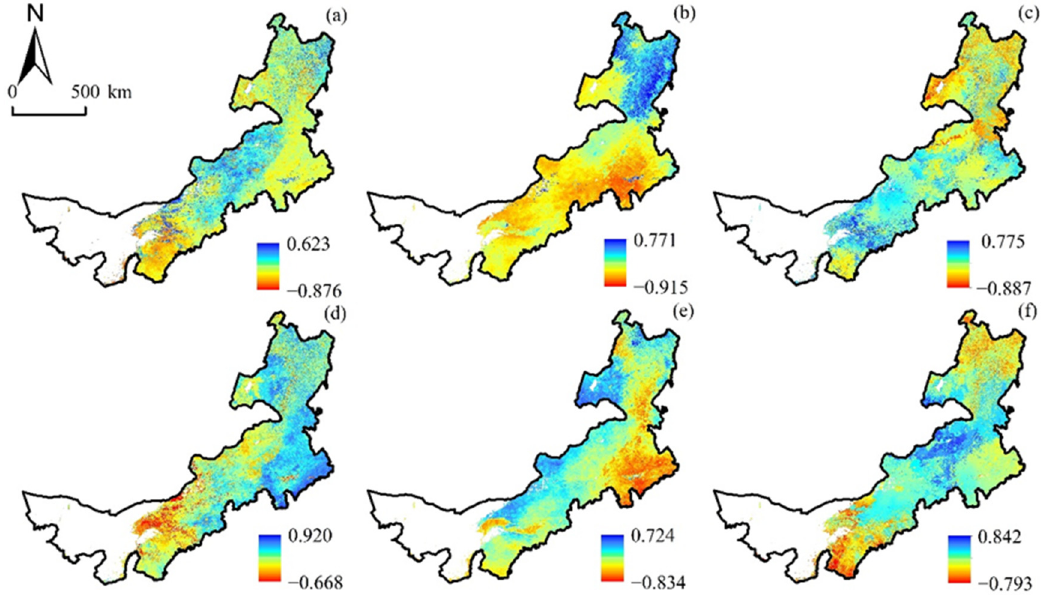
Figure 8. Correlation distribution map of eWUE with precipitation and temperature in different seasons. ( a – c ) Correlation between eWUE and precipitation for spring, summer and autumn; ( d – f ) correlation between eWUE and temperature for spring, summer and autumn.